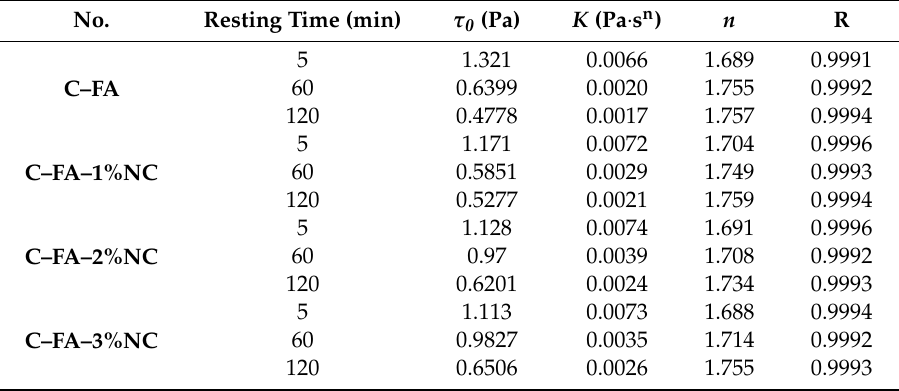
Figure 16. Influence of resting time on τ 0 . Table 5. Rheological parameters of C–FA paste with NC.